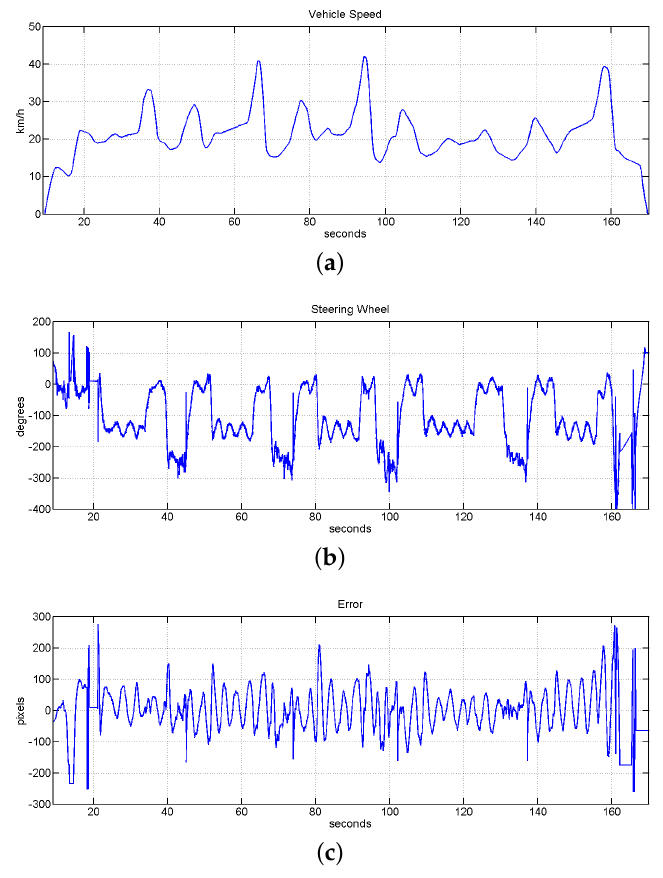
Figure 23. Evolution of the system under speed limits with human speed control experiment. ( a ) Vehicle speed evolution with a top speed of 42 km/h; ( b ) evolution of the steering wheel position; ( c ) evolution of the error measured in pixels, the value of RMSE for this test is equal to 9.1397